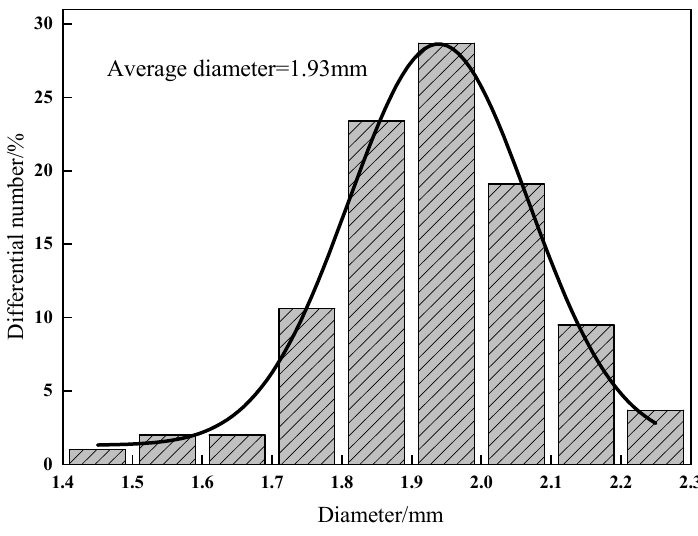
Figure 9. Histogram of capsule size distribution.